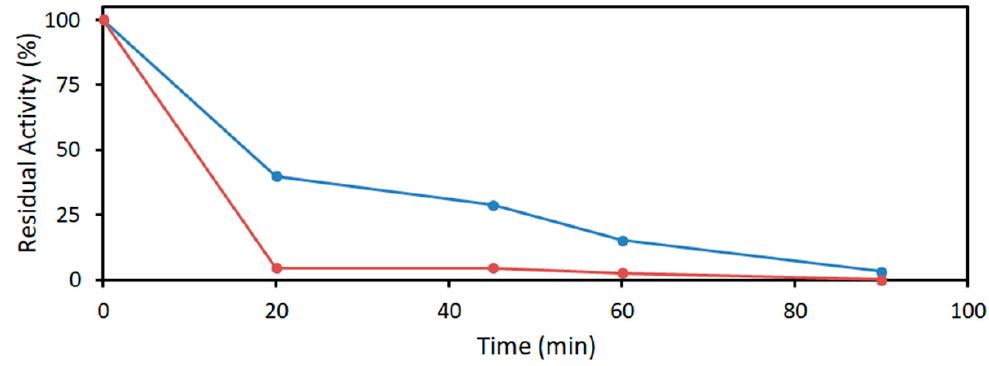
Figure 3. DERA inactivation of the two variants Pa DERA (blue) and Ec DERA (red) upon incubation with 100 mM acetaldehyde at 25 °C in 100 mM TEA buffer pH 7.0. A specific activity of 11.9 U/mg for Pa DERA and 1.7 U/mg for Ec DERA were normalized at 100%.